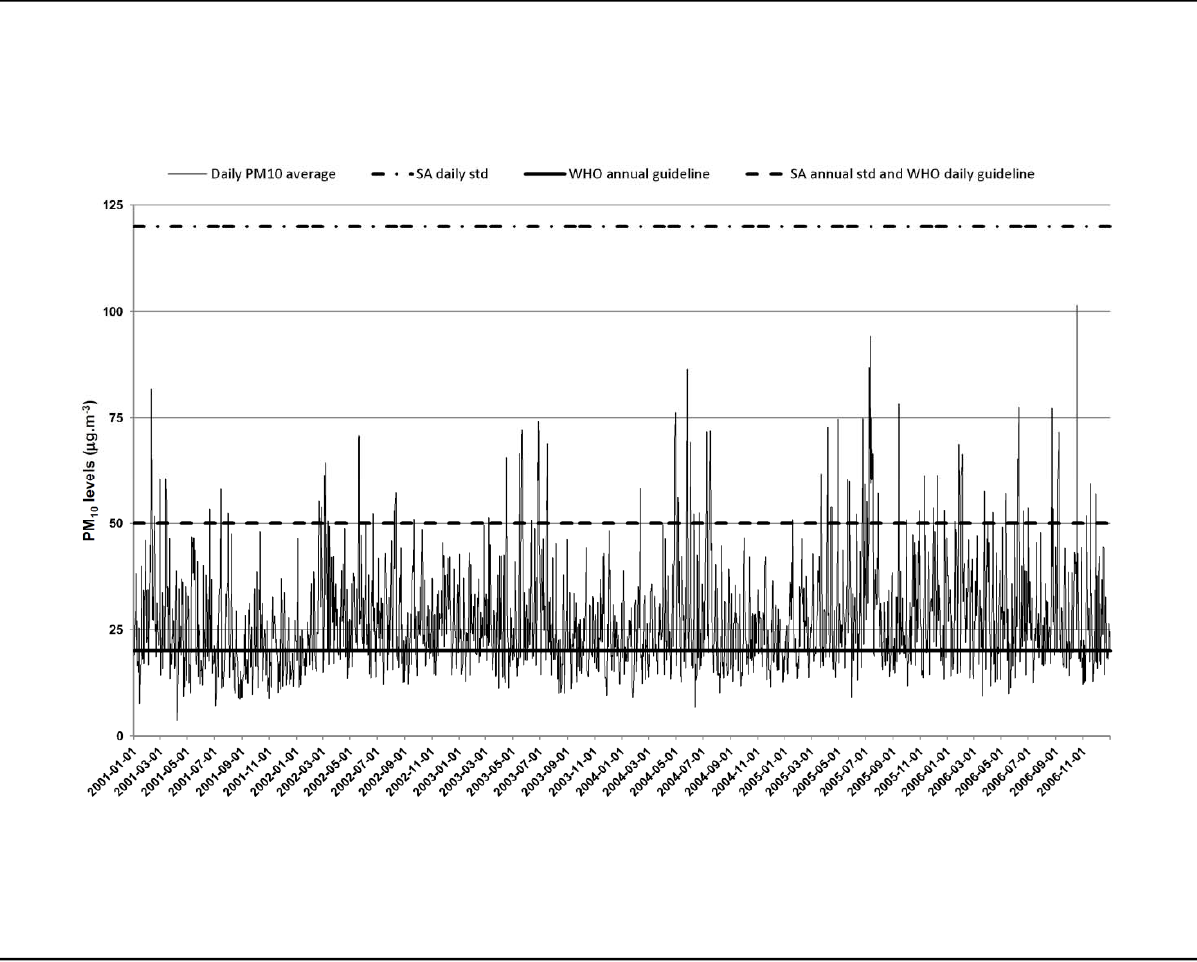
Figure A3. Time series of PM